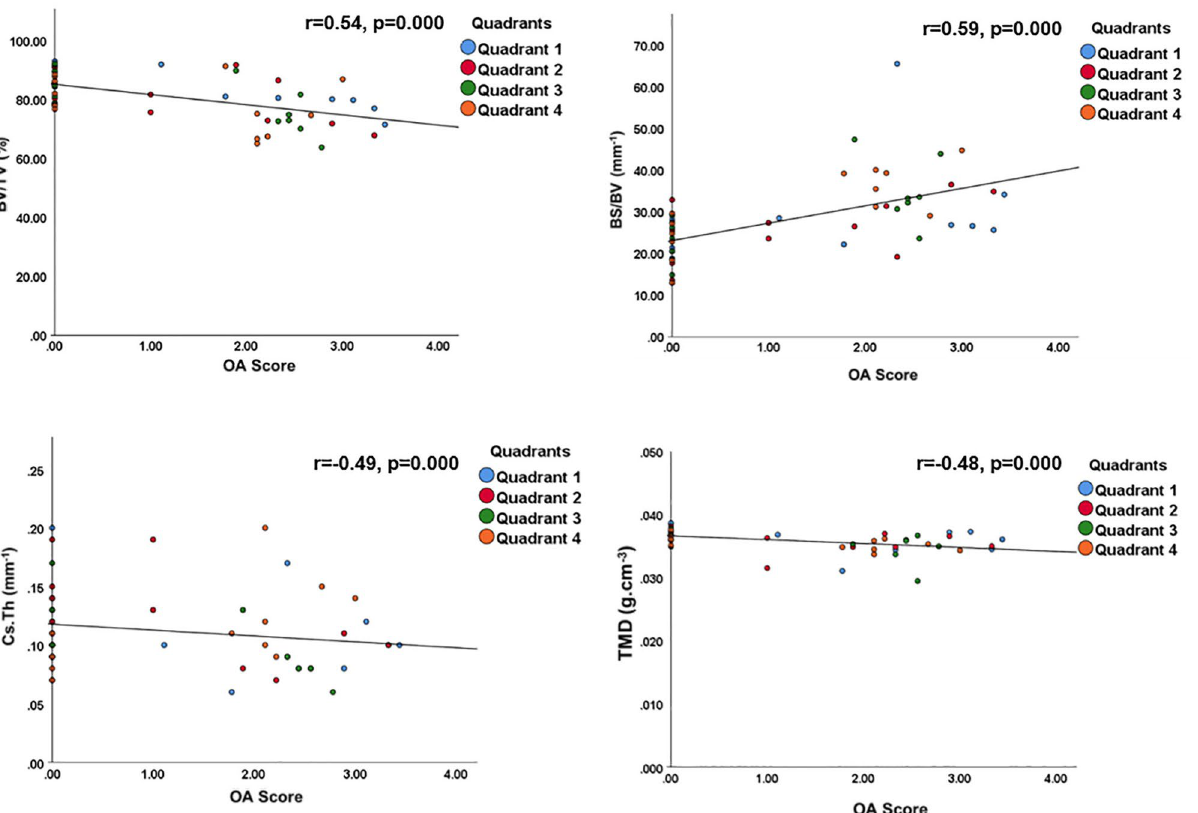
Figure 3. Subchondral plate correlation with OA severity in the entire femoral head. Bone volume fraction (BV/TV), thickness (Cs.Th), tissue mineral density (TMD), and bone-specific surface (BS/BV) presented as a function of OA severity. P values and Spearman correlation coefficients are indicated on figures. p < 0.0001 was considered